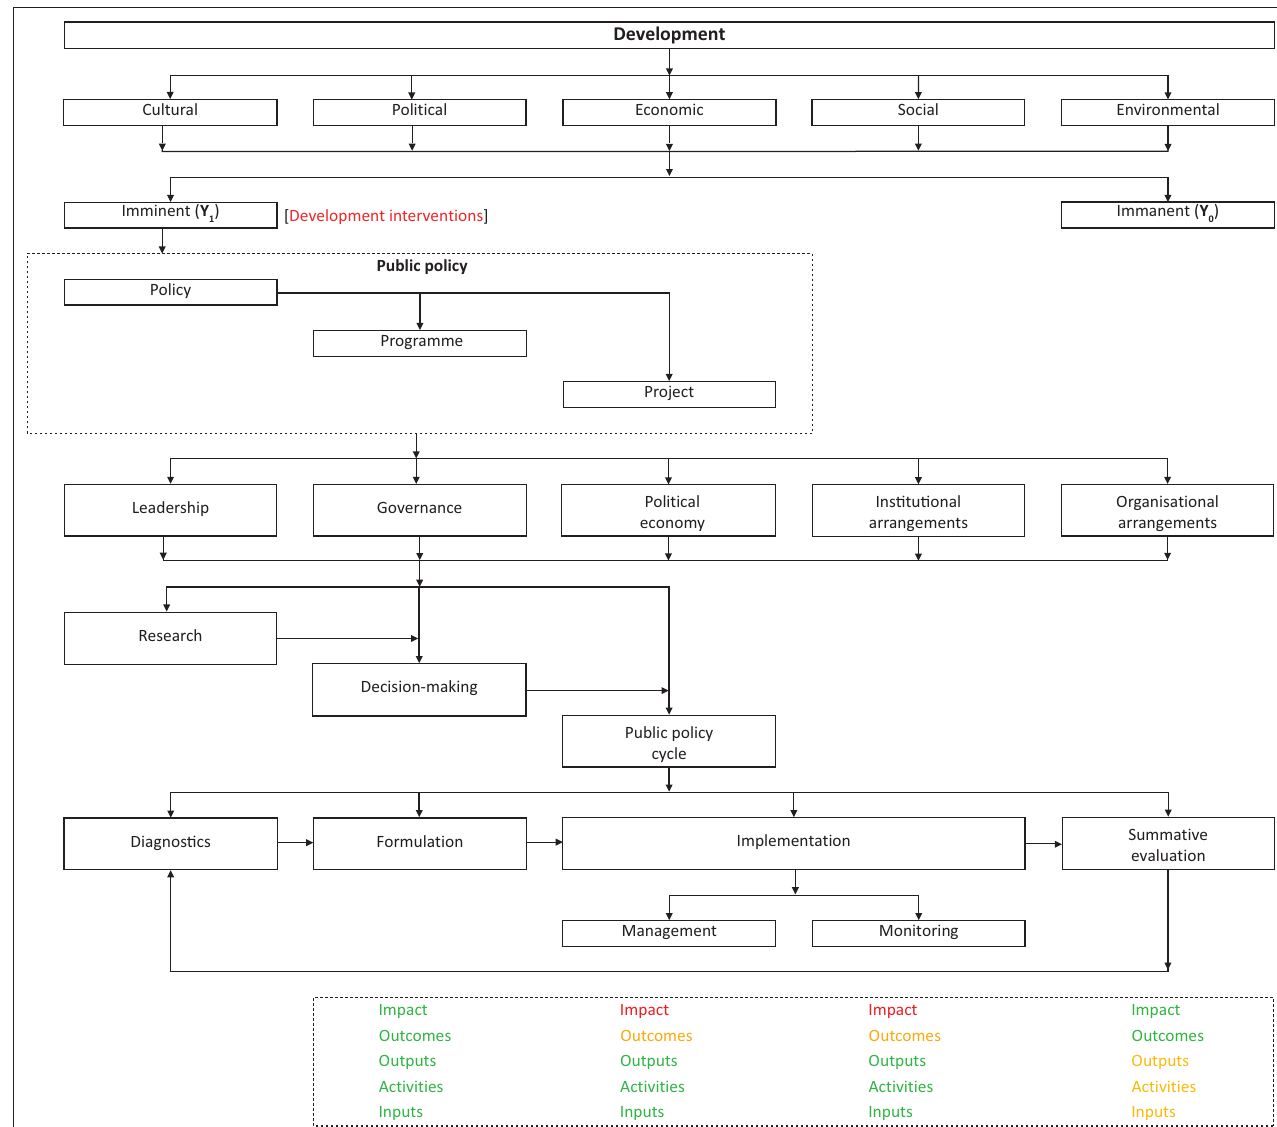
FIGURE 6: Illustrating the relationship between development (and its components and processes), public policy (and its components and processes) and the key stages of the public policy cycle